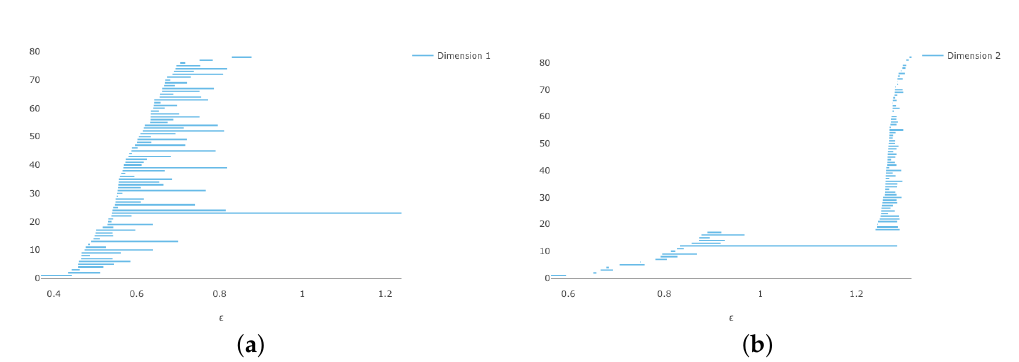
Figure 11. Vietoris–Rips persistence diagrams for 150 points on G 2 ( R 4 ) ( a ) H 1 persistence and ( b ) H 2 persistence.